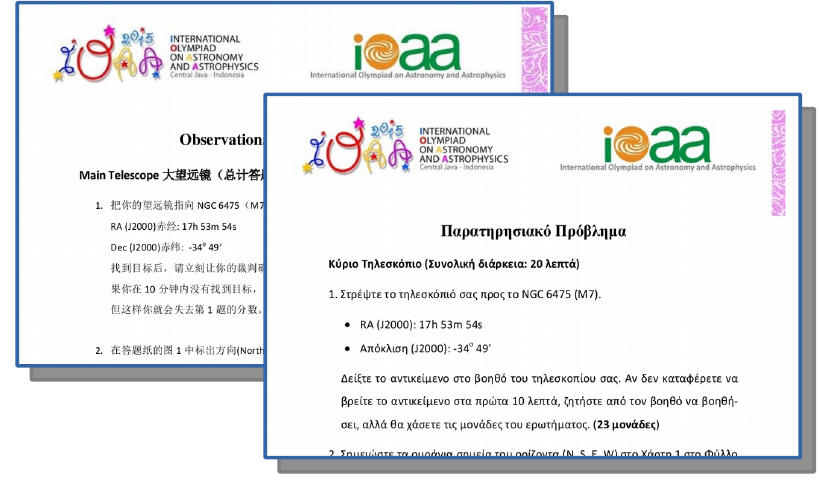
Fig. 1. Illustration of papers in different languages (from the 2015